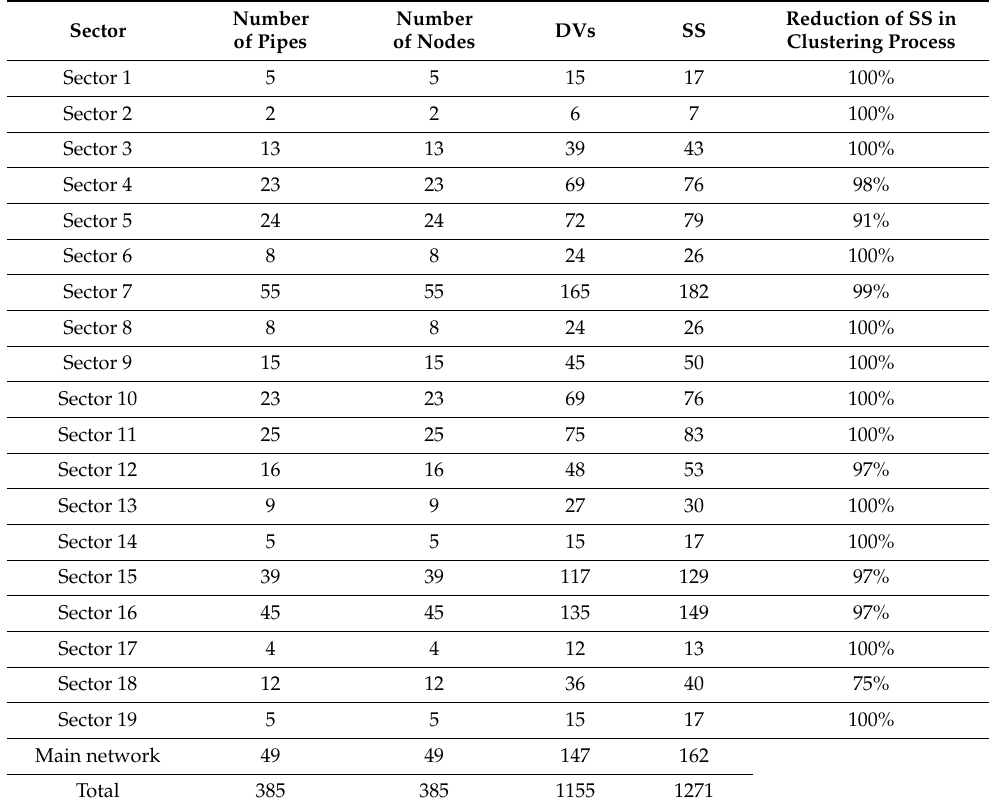
Table 3. Elements, magnitude of SS and percentage of reduction in the clustering stage of the sectors that make up the ES-N